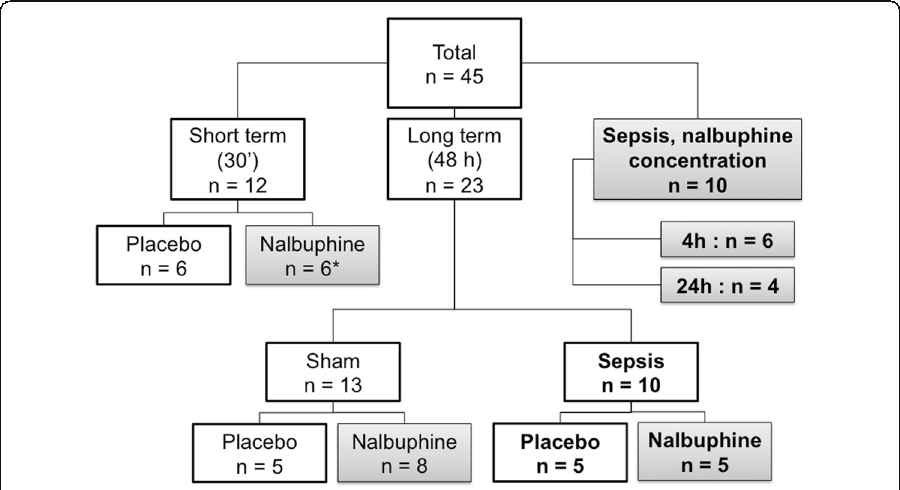
Asterisk (*): nalbuphine concentration at 15 min measured in plasma samples from short-term